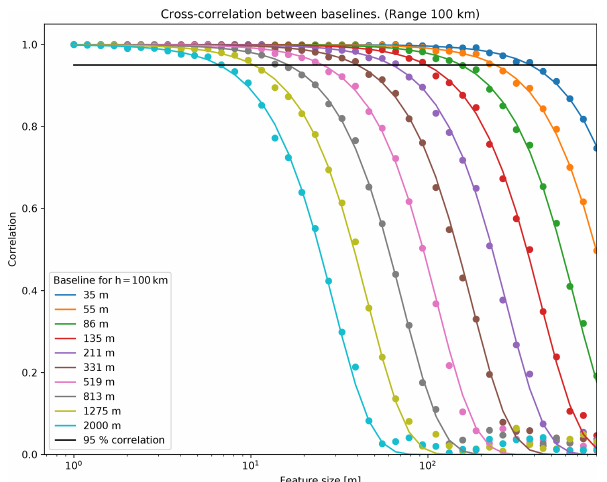
Figure 4. Cross-correlation between the signals in EISCAT 3D re- ceivers displaced by distance d . The solid lines show the magni- tude of the normalized cross-correlation function; see Eq. (20) with L = (L/ 2 ) 2 I . The dots show the numerical estimations of the cross- correlation; see Eq. 16.